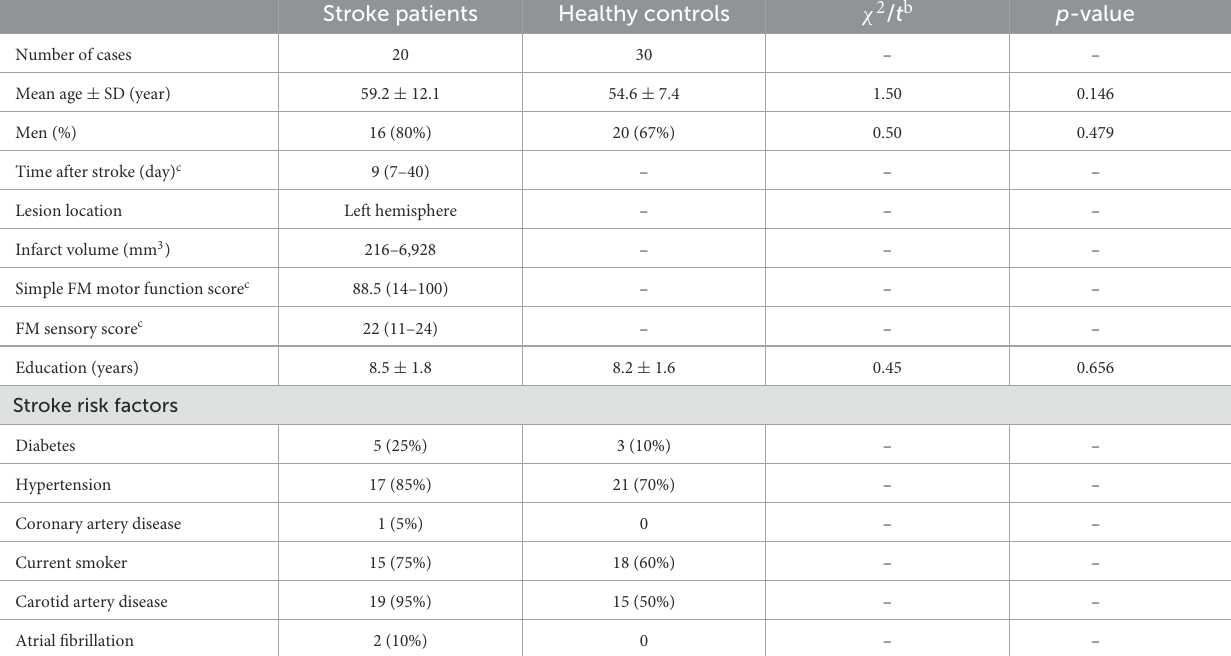
TABLE 1 Demographic and clinical characteristics of 50 participants a